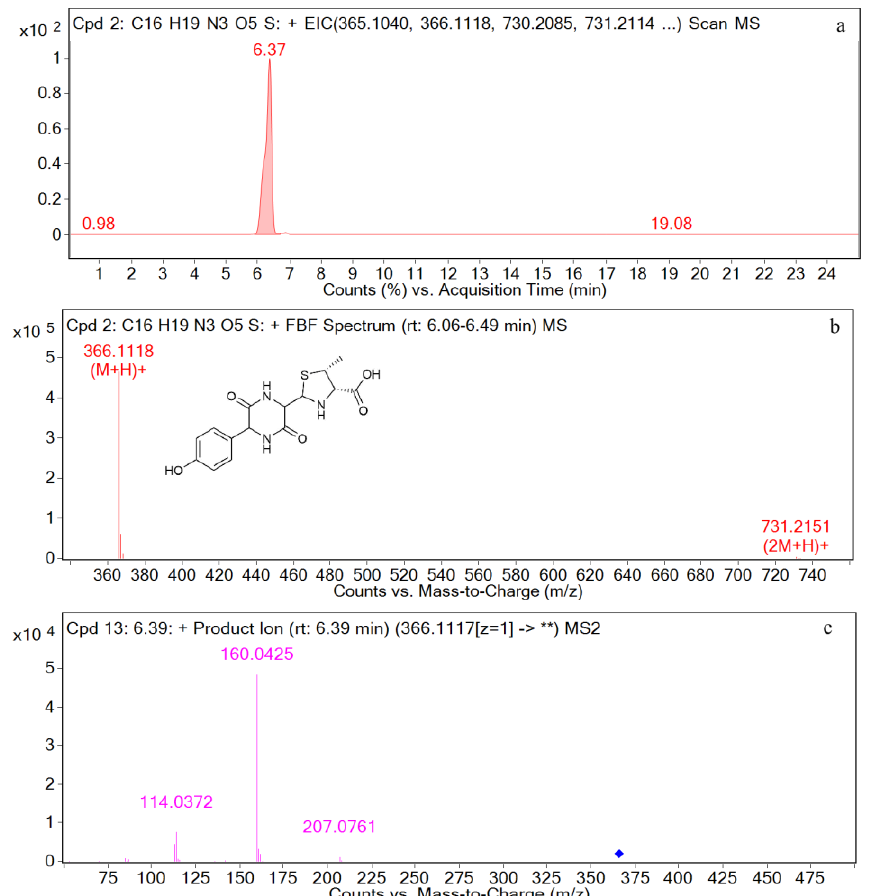
Figure 6. EIC and mass spectrometry results for amoxicillin diketopiperazine. ( a ): EIC spectrometry results for amoxicillin diketopiperazine; ( b ): Mass spectrum of amoxicillin diketopiperazine; ( c ): Two-stage mass spectral data of amoxicillin diketopiperazine.